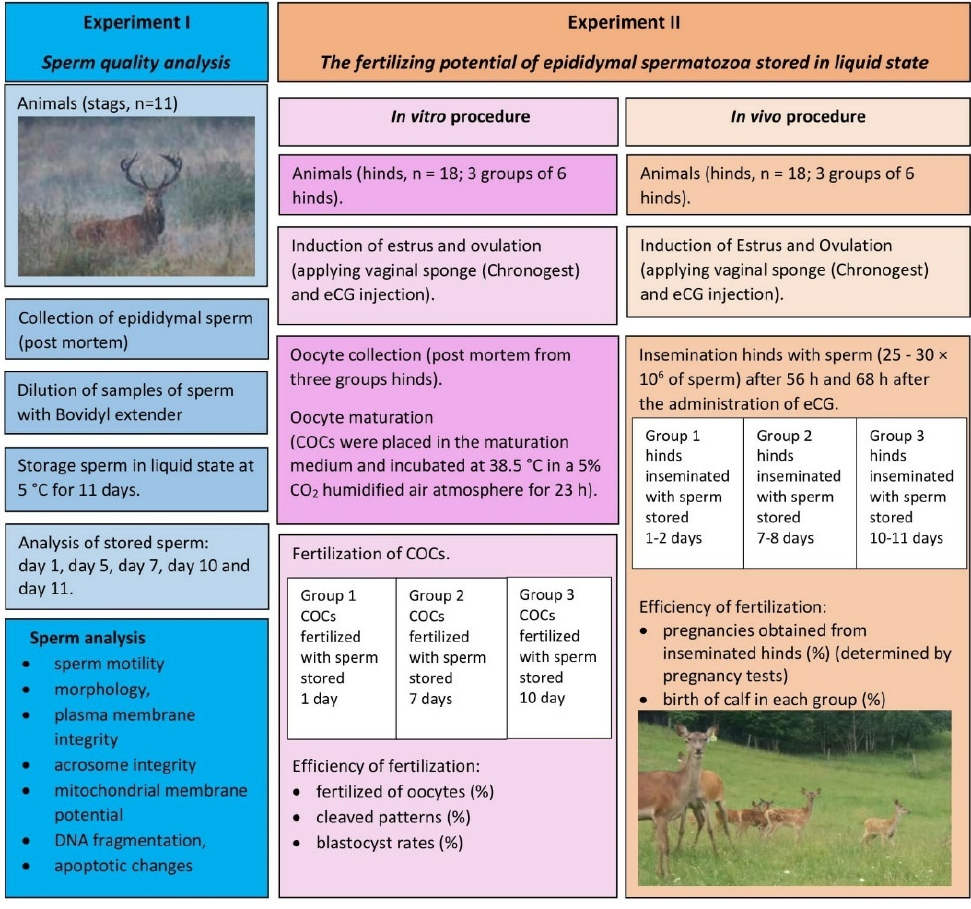
Figure 2. The diagram of the experiments.